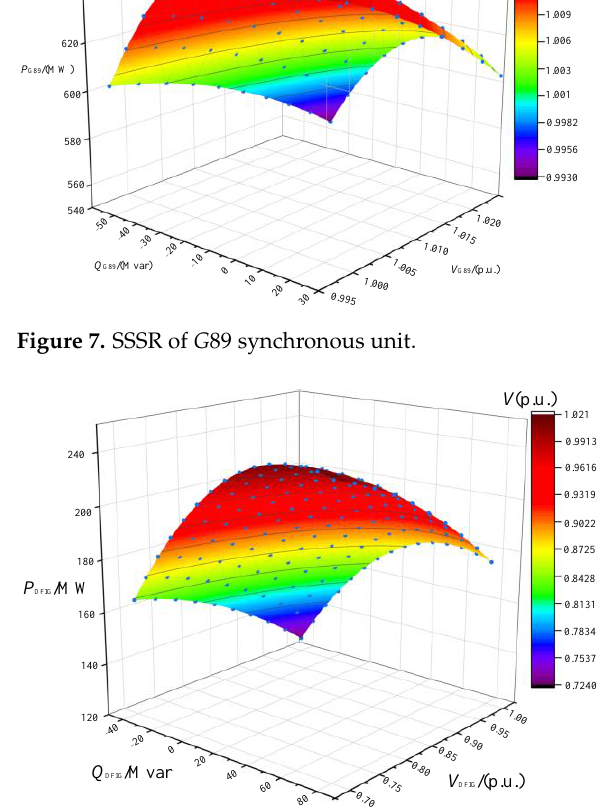
Figure 8. SSSR of G DFIG 25 wind power unit.